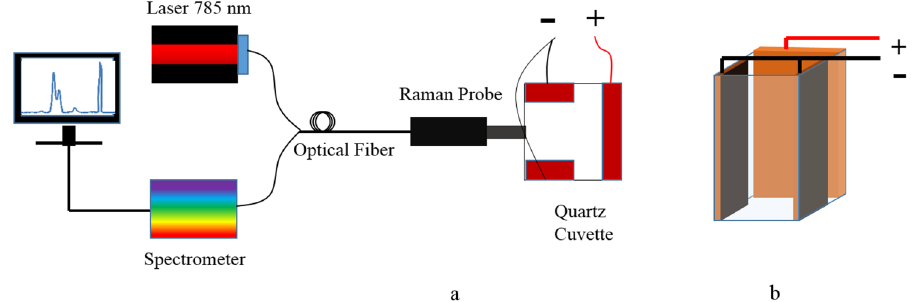
Figure 1. ( a ) Drawing of the experimental setup for preparing real time SERS substrate and recording the Raman spectrum simultaneously. ( b ) Quartz cuvette used as the electrolysis chamber and as a container simultaneously for the solution that the Raman spectrum is of interest. The anode and cathode electrode dimensions are 50 mm × 8.5 mm × 0.25 mm and 50 mm × 5.5 mm × 0.25 mm respectively. The Raman signal was recorded head-on from the anode surface.